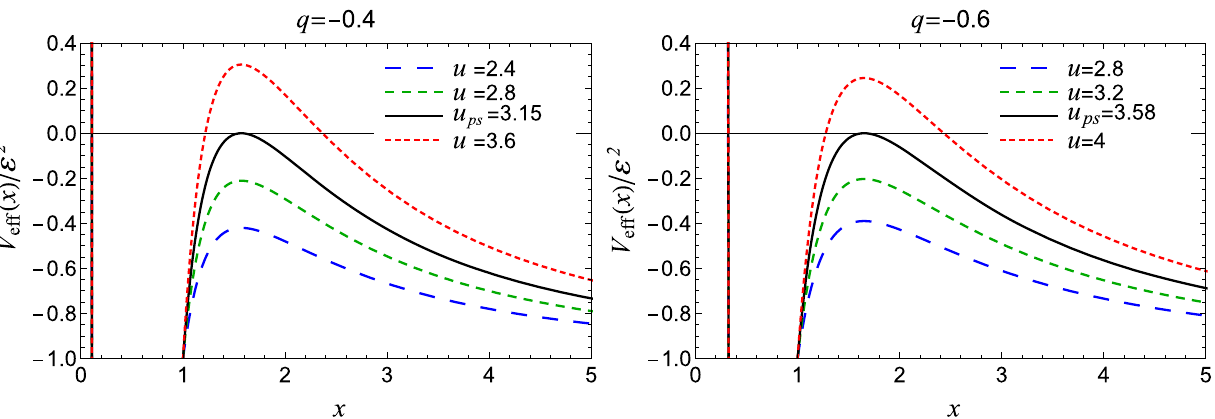
Fig. 3 Variation of the effective potential V eff as a function of radial coordinate x , for different values of q and u . The photons with critical impact parameter ( u ps ) (black solid curve) make unstable circular